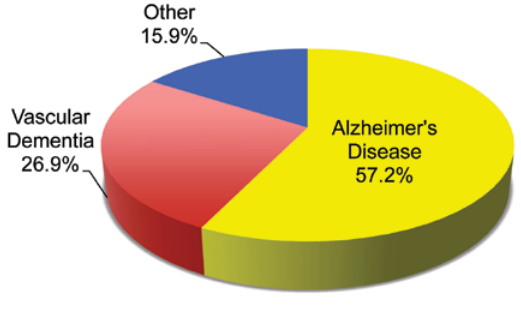
Figure 6 Proportional contribution of different types of dementia to the overall burden in Africa.